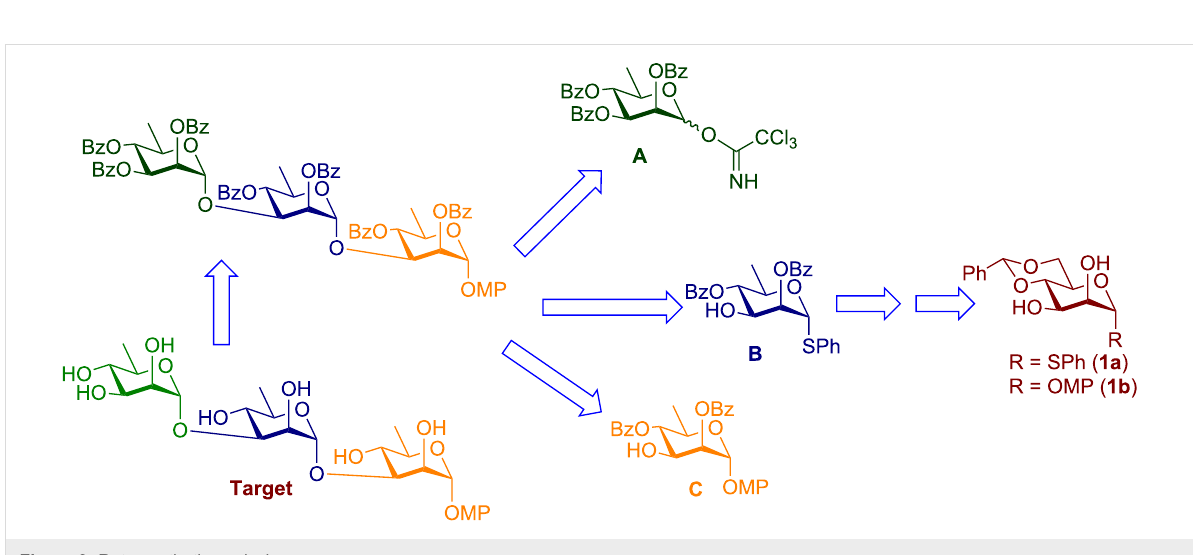
Figure 2: Retrosynthetic